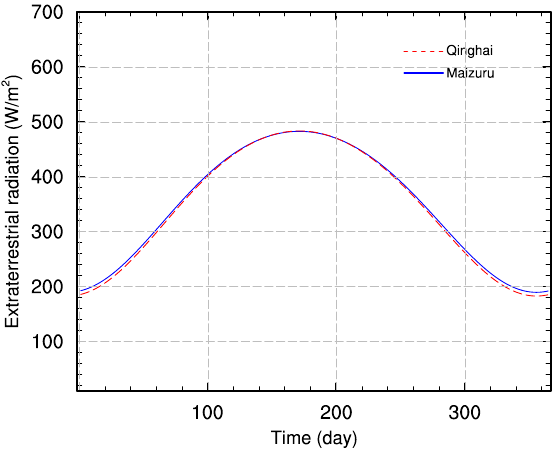
Figure 1. The extraterrestrial horizontal radiation H 0 (W/m 2 ) series for two